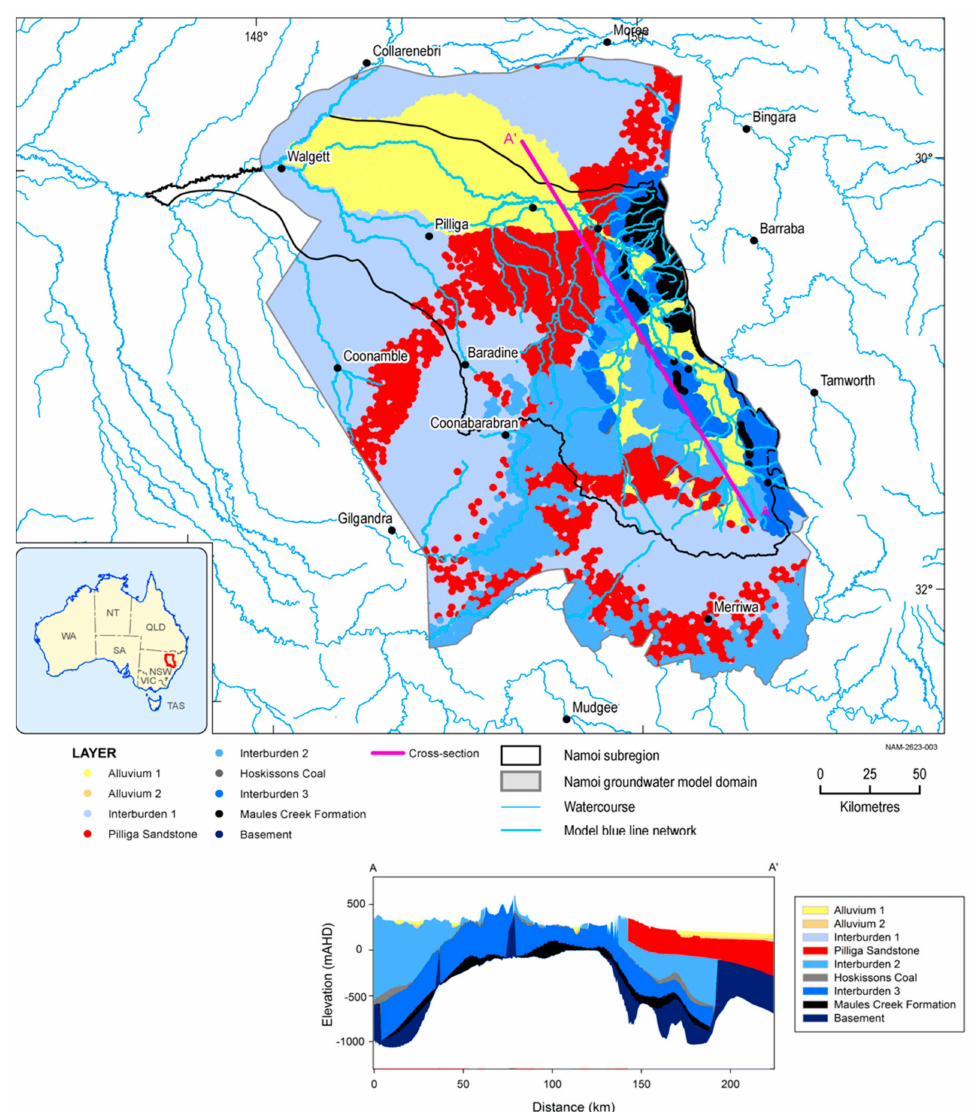
Figure 2. Plan and cross-section view of the model area indicating the important outcropping units and hydrostratigraphic units